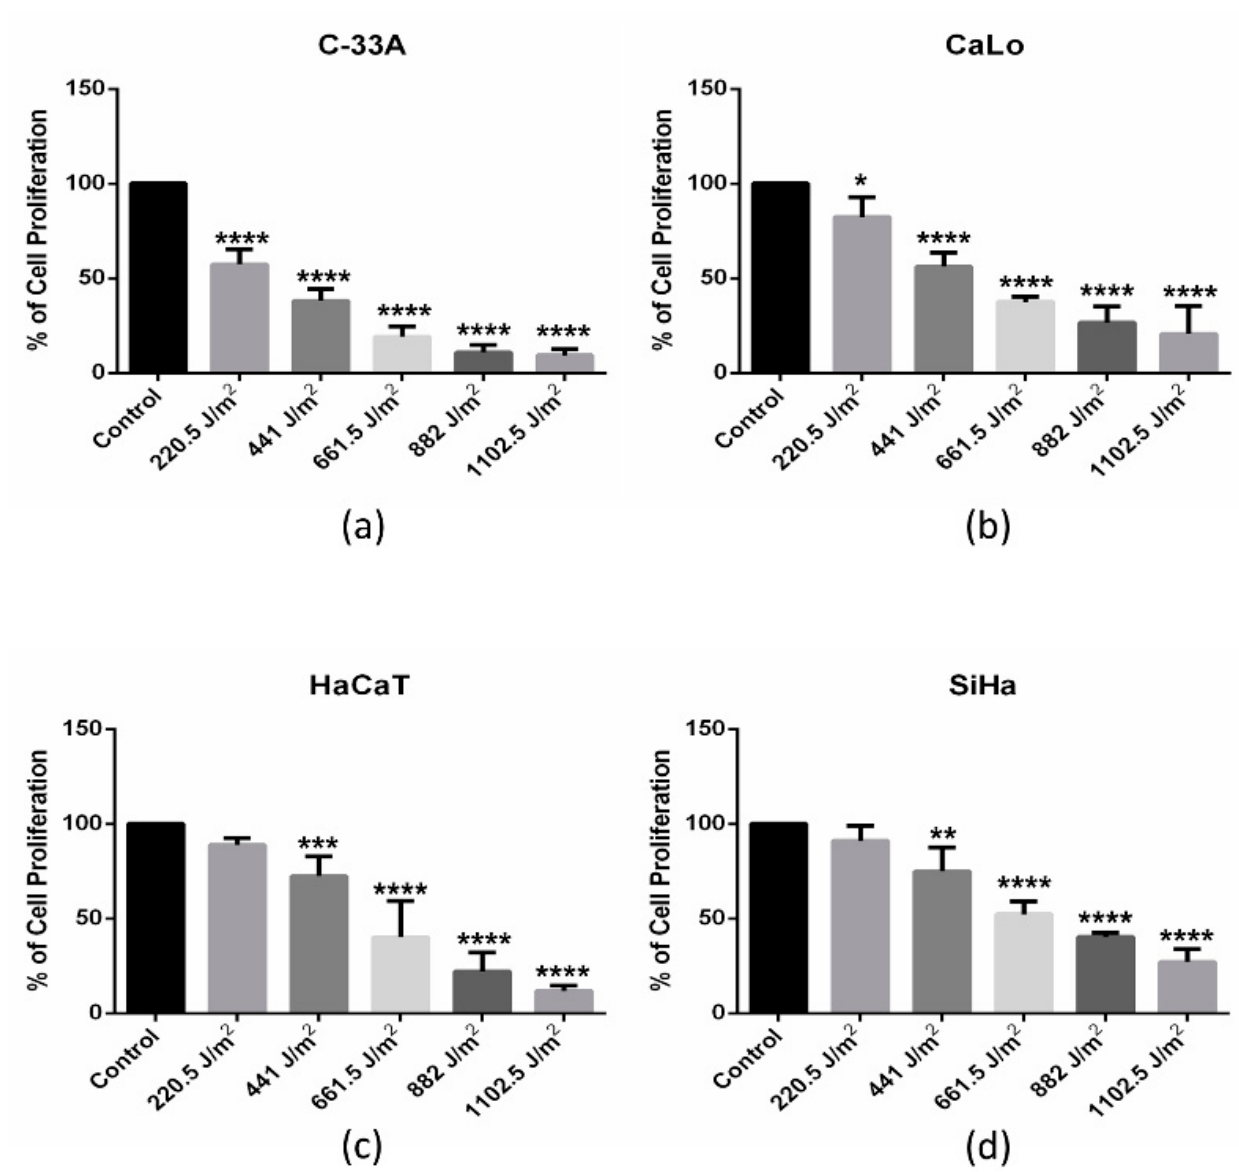
Figure 1. UVB inhibits proliferation of cervical cancer cell lines in a dose-dependent manner. ( a ) C-33A, ( b ) CaLo, ( c ) HaCaT and ( d ) SiHa cells were treated with increasing doses of UVB. After 72 h of incubation, cellular proliferation was analyzed. Bars represent mean and standard deviation of three independent experiments ( p < 0.05) * = 0.0415, ** = 0.0047, *** = 0.0002, **** = <0.0001. Control cells were not UVB irradiated.